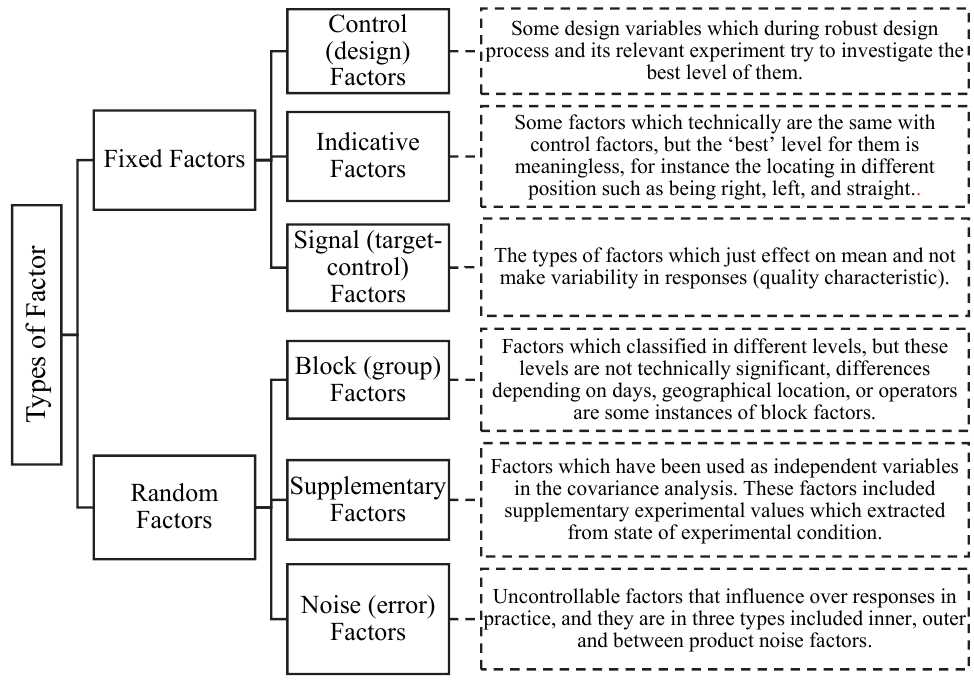
Fig. 6. Different types of factors which influence process in practice